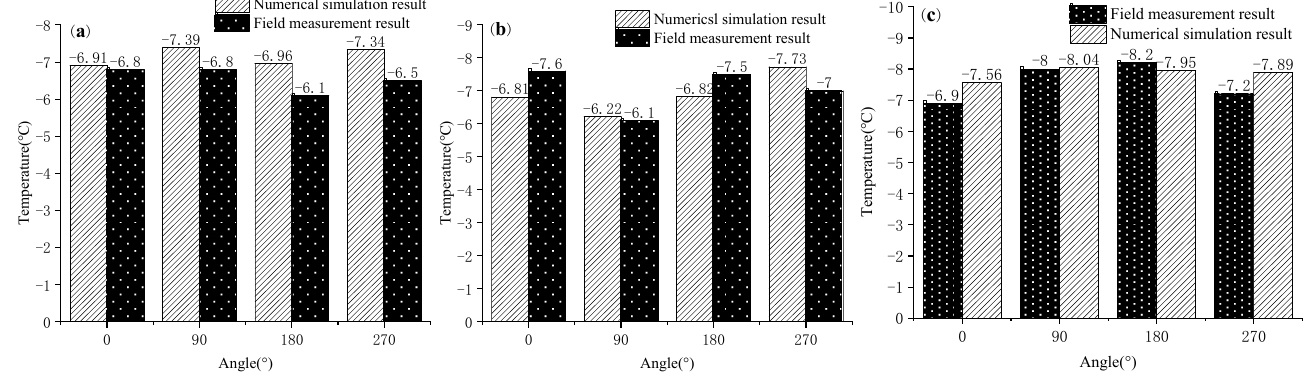
Figure 5. Comparison between simulated and measured results of side wall. ( a ) The − 120.5 m fine sand (frozen 105 d). ( b ) The − 190 m clay (frozen 121 d). ( c ) The − 216 m sandy clay (frozen 131 d).